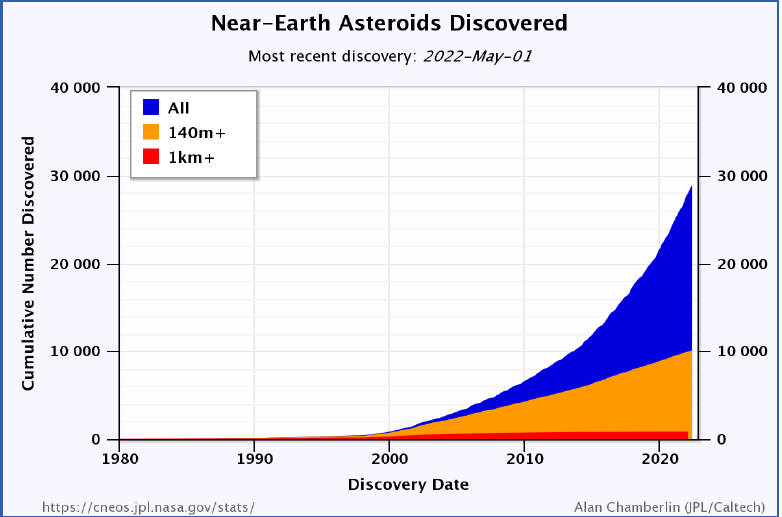
Figure 14. Near-Earth asteroids discovered as of 1 May 2022